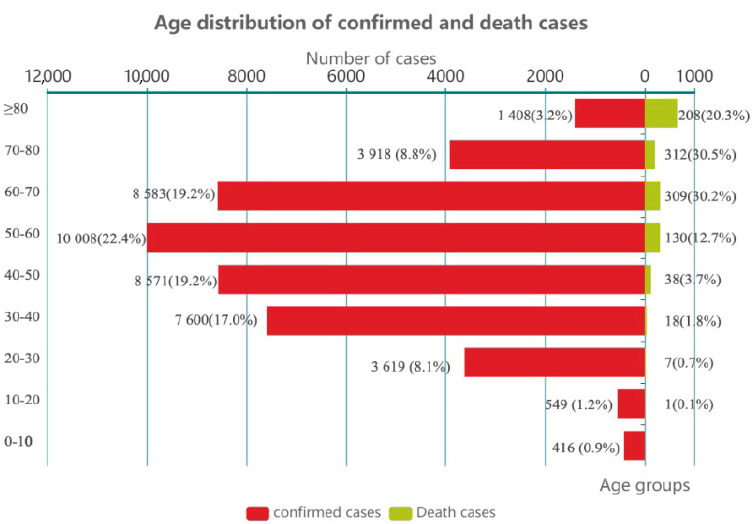
Figure 2. Age distribution of confirmed and death cases .